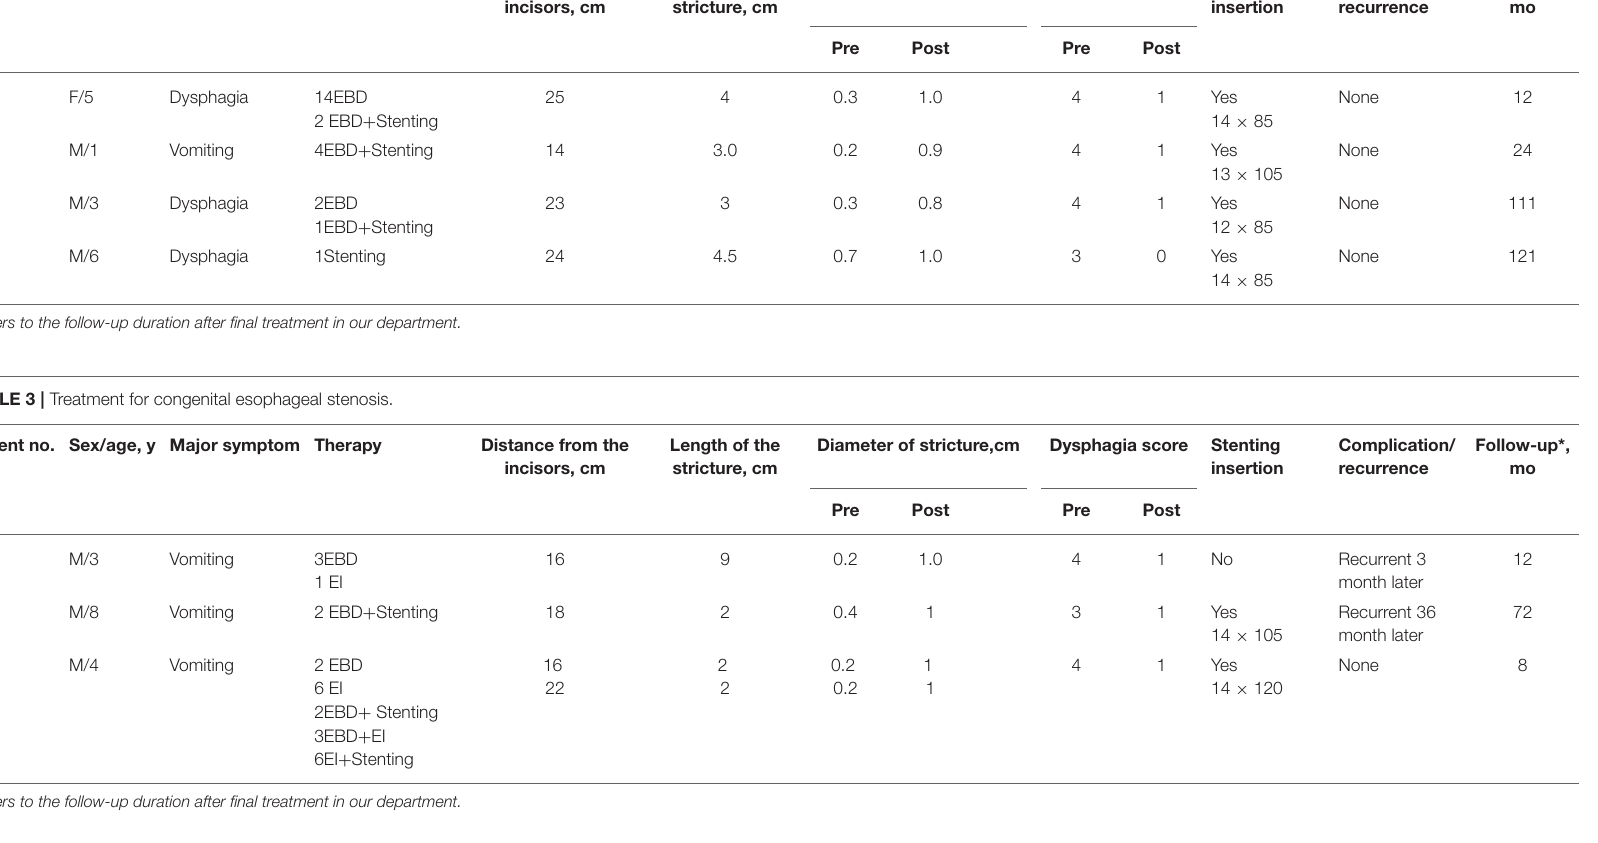
TABLE 2 | Treatment for esophageal stenosis after surgical repair of esophageal arteria. Patient no. Sex/age, y Major symptom Therapy